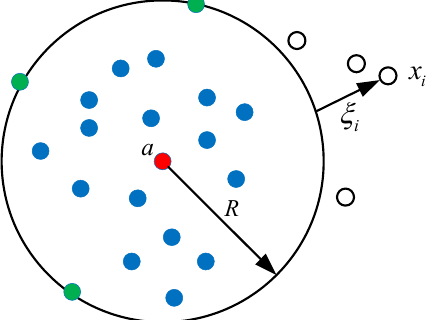
Figure 2. Diagram of the hypersphere classification.